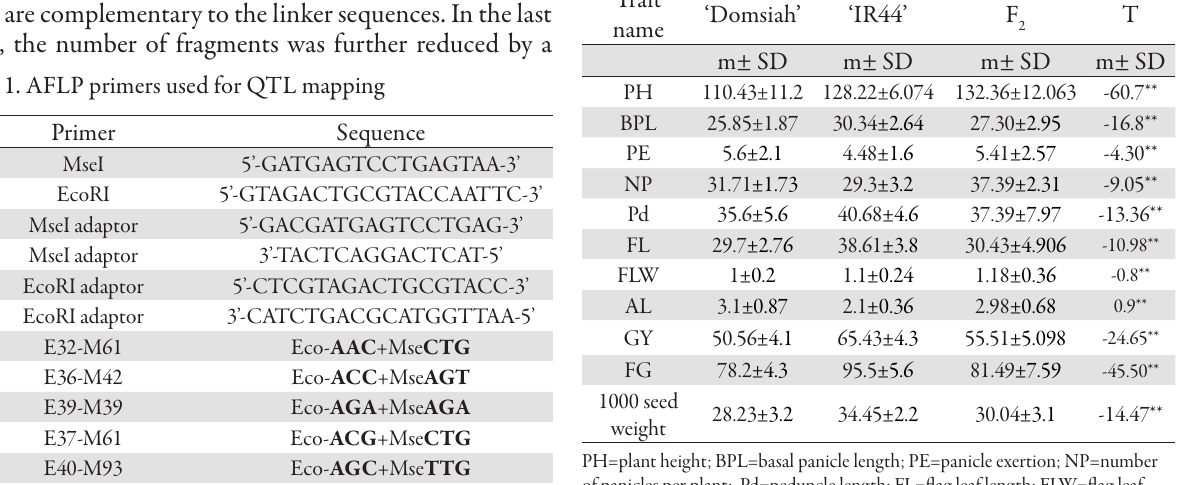
Tab. 2. Phenotypic value of parents and F